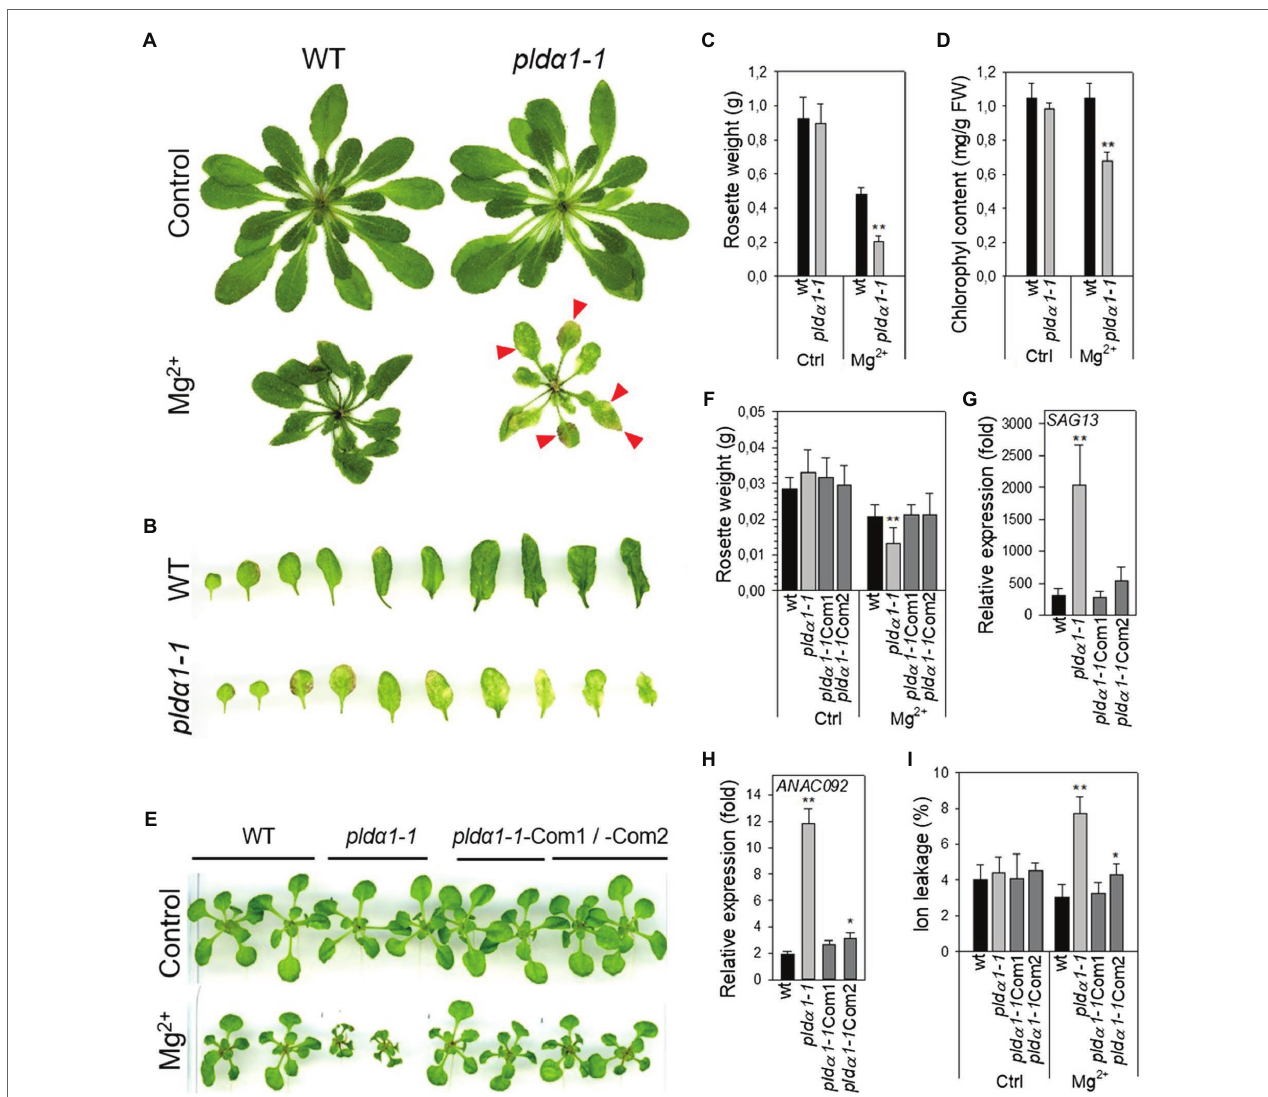
FIGURE 2 | High Mg 2+ leads to premature senescence in pld α 1-1 . (A) Phenotype of WT and pld α 1-1 grown hydroponically on high Mg 2+ , red arrows point to senescent parts of leaves. (B) Leaves of plants grown on high Mg 2+ . (C) Weight of rosettes. (D) Chlorophyll content, (A–D) 3-week-old hydroponically grown plants were treated with 15 mM MgSO 4 and grown for another 16 days, values represent means ± SD, n = 6. (E) Phenotype of WT, pld α 1-1 , pld α 1-1 Com1 and pld α 1- 1 Com2 plants grown on agar plates on high Mg 2+ . (F) Weight of rosettes. (G,H) Transcript level of SAG13 and ANAC092 in rosettes. Transcription was normalized to a reference gene SAND and the transcription of non-treated plants was set to one. Values represent means ± SE, n = 12. (I) Ion leakage, values represent means ± SD, n = 7. (E–I) Ten-day-old Arabidopsis seedlings were transferred on agar plates containing 15 mM MgCl 2 and grown for another 7 days, Student’s t test, asterisk indicate significant difference in comparison with WT * p < 0.05; ** p <